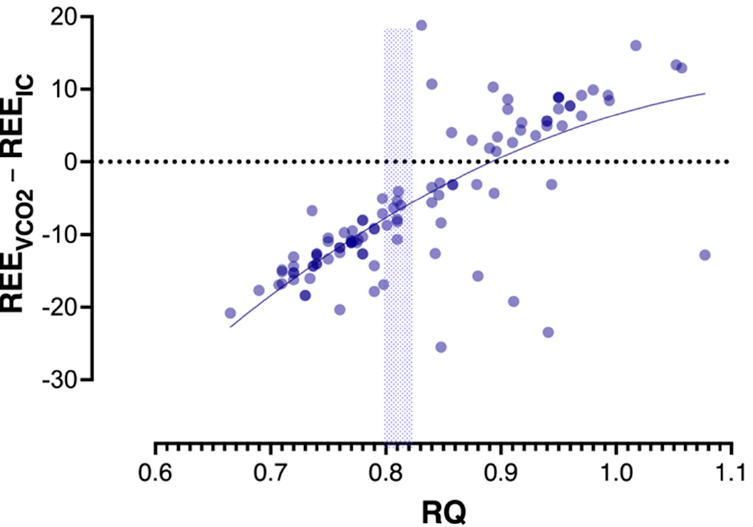
Figure 3. Scatterplot of non-linear least squares regression fit of resting energy expenditure (REE) based on volumetric carbon dioxide production (VCO 2 ) measurements (REE VCO2 ) predictions expressed as paired REE VCO2 –REE calculated by indirect calorimetry (IC) (REE IC ) differences over the range of recorded respiratory quotient (RQ) values (polynomial (quadratic) equation). Analysis of areas under the receiver operating characteristic curves (AUROCs) revealed that cutoffs of RQ = 0.80 predict 89% of REE VCO2 underestimating REE IC (sensitivity 0.99; specificity 0.89) and RQ = 0.82 predict 56% of REE VCO2 overestimating REE IC (sensitivity of 0.99; specificity 0.56) (areas outside the shaded